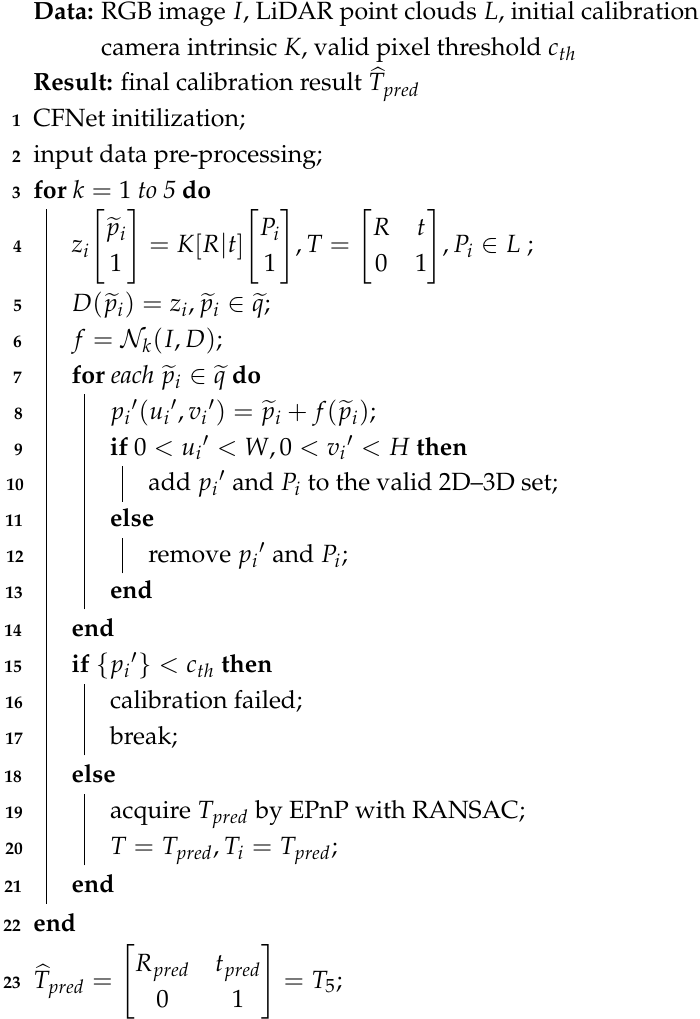
Algorithm 1: Calibration iterative refinement Data: RGB image I , LiDAR point clouds L , initial calibration parameters T , camera intrinsic K , valid pixel threshold c